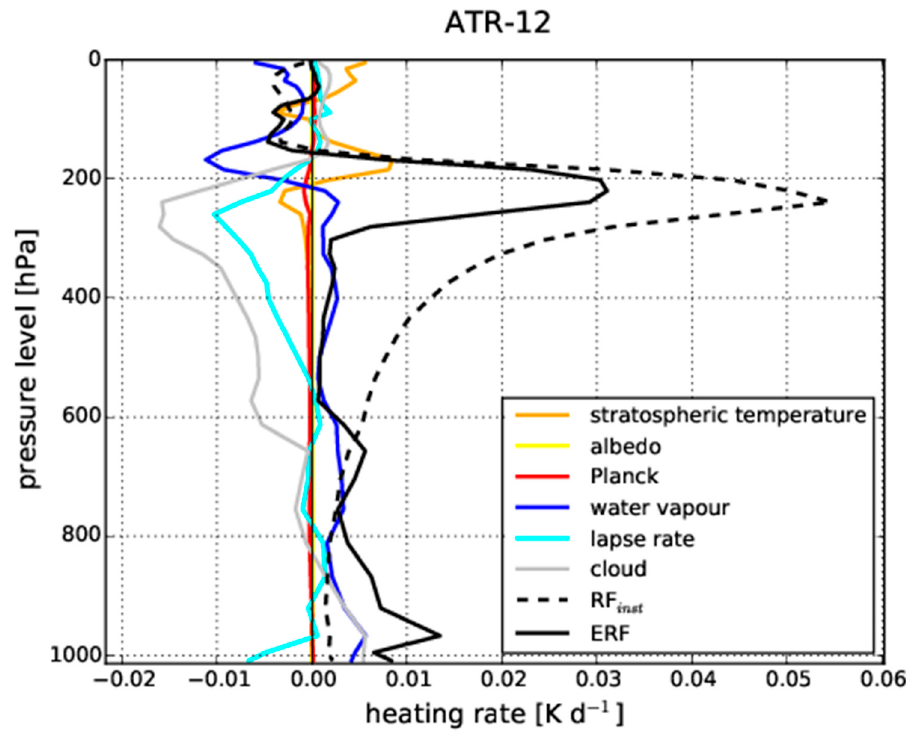
Figure 4. Global mean atmospheric heating rates (in K d − 1 ) induced by various rapid radiative adjustments in the ATR-12 simulations, explaining the difference between the instantaneous contrail cirrus heating rates (dashed black curve) and the effective contrail cirrus heating rates (solid black curve). The individual adjustments (colored curves) affect different atmospheric altitudes with different magnitude (see text).